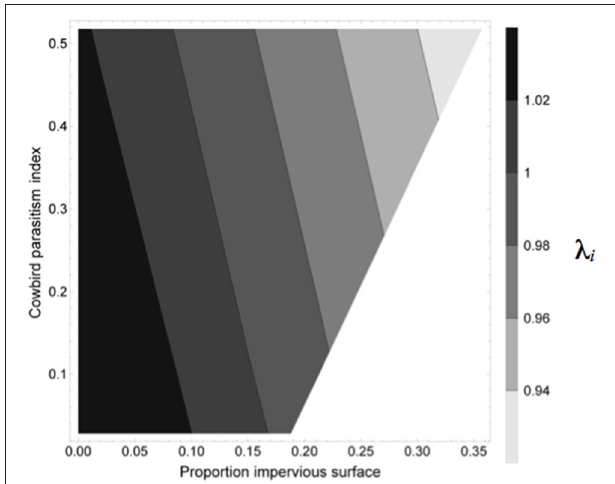
FIGURE 4 | Contour plot showing the relationship of combinations of proportions of impervious surface and index of cowbird parasitism (i.e., proportion of cowbird parasitized nests × number of cowbird eggs per nest) to mean lambda per site ( λ i